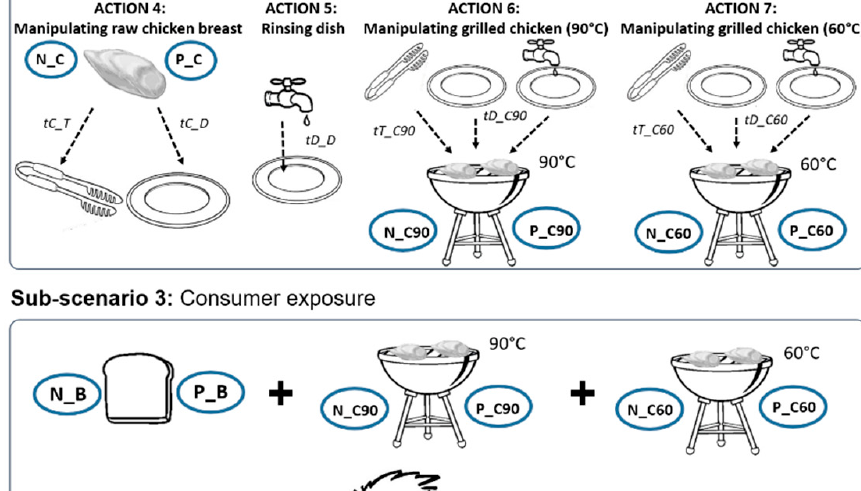
Table 1. Detailed description of the model parameters including definitions, default numerical values and sources of in- formation (ESBL = ESBL-/AmpC-producing E. coli ).